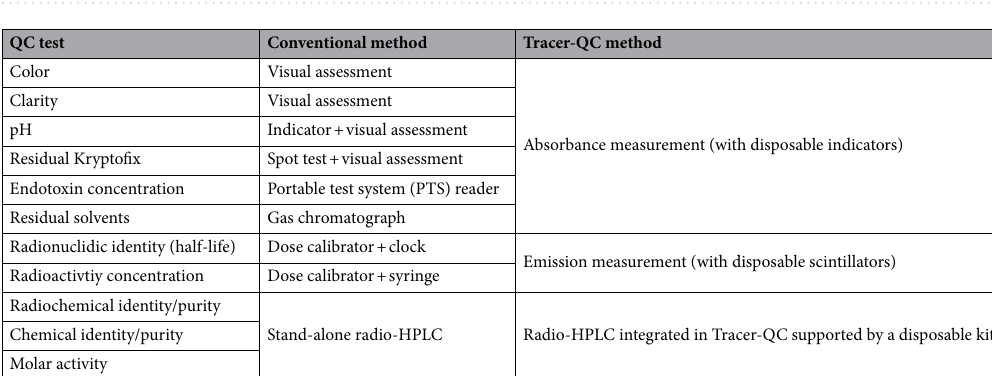
Figure 4. Components of the Tracer-QC platform.